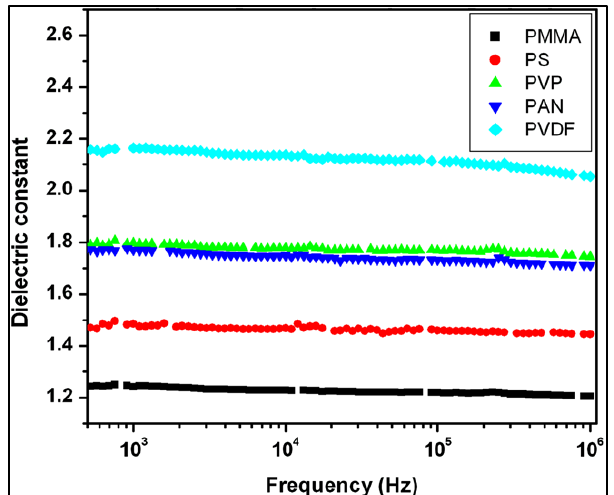
Figure 16. Dielectric constant of PAN at 8 wt.% in the radio frequency range [2] .